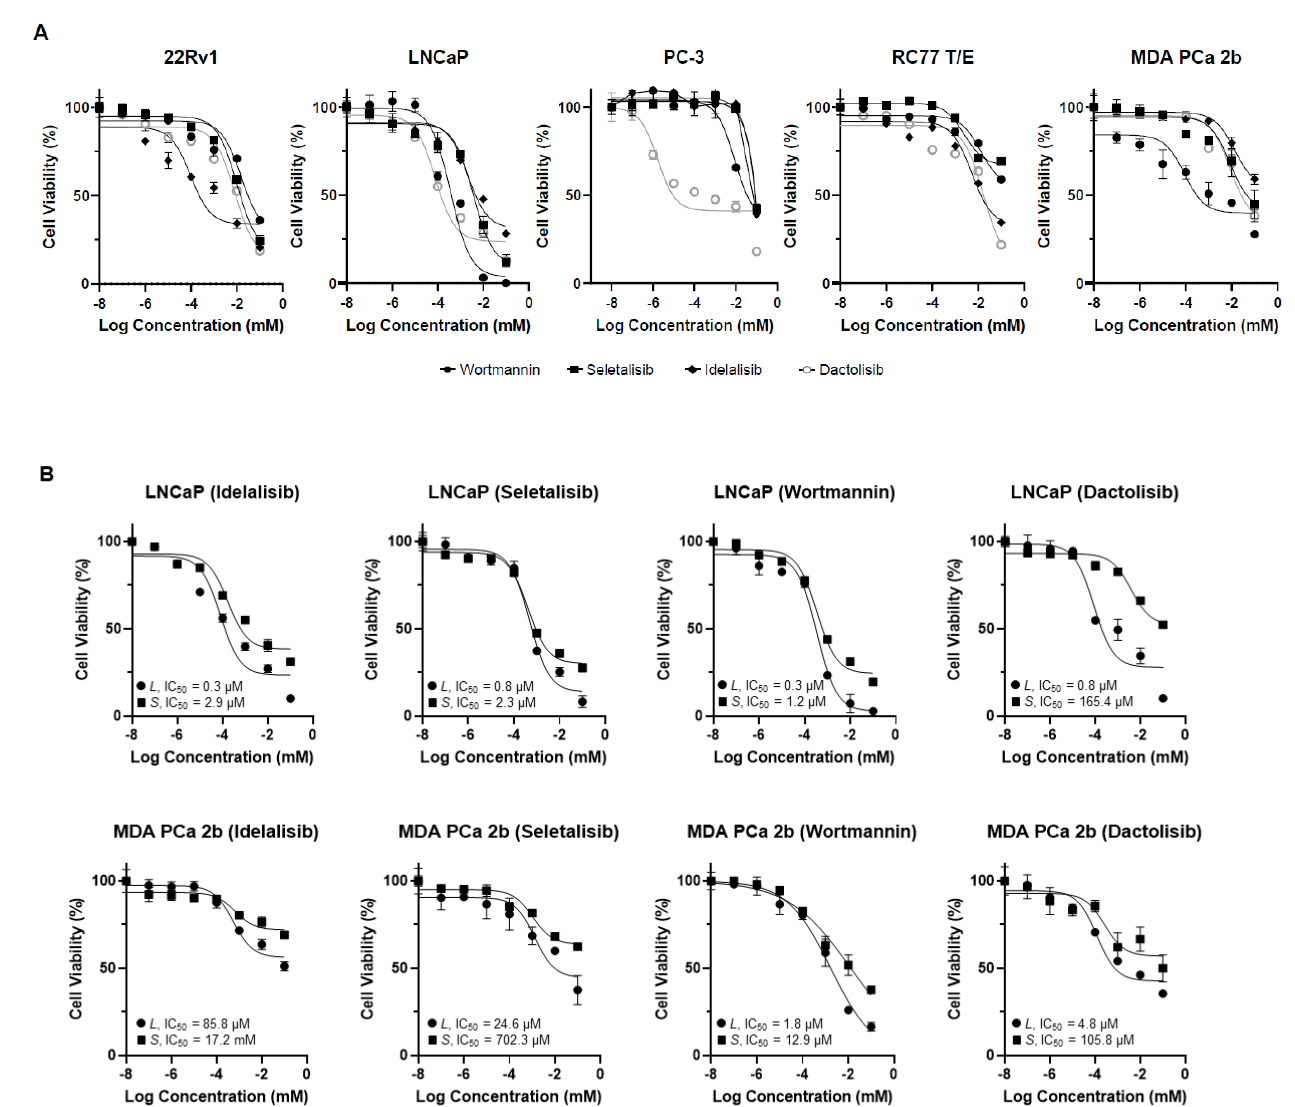
Figure 2. Cell vi ability curves of the PCa cells treated with PI3Kδ -specific, pan-PI3K, and PI3K/mTOR inhibitors by MTT assays. ( A ) Cell viability curves from EA PCa cell lines (22Rv1, LNCaP, and PC-3) and AA PCa cell lines (RC77 T/E and MDA PCa 2b) in presence of Idelalisib, Seletalisib, Wortmannin, and Dactolisib at concentrations from 0 to100 μM. ( B ) Cell viability curves from PIK3CD-L- and PIK3CD-S- expressing LNCaP and MDA PCa 2b cells in the presence of four drugs at concentrations from 0 to100 μM. All the MTT assay results (in A and B) were calculated based on six experimental repeats for each drug dose, and the data values represent mean ± SD. The IC 50 values were determined from the viability curves by using GraphPad Prism 9 program.